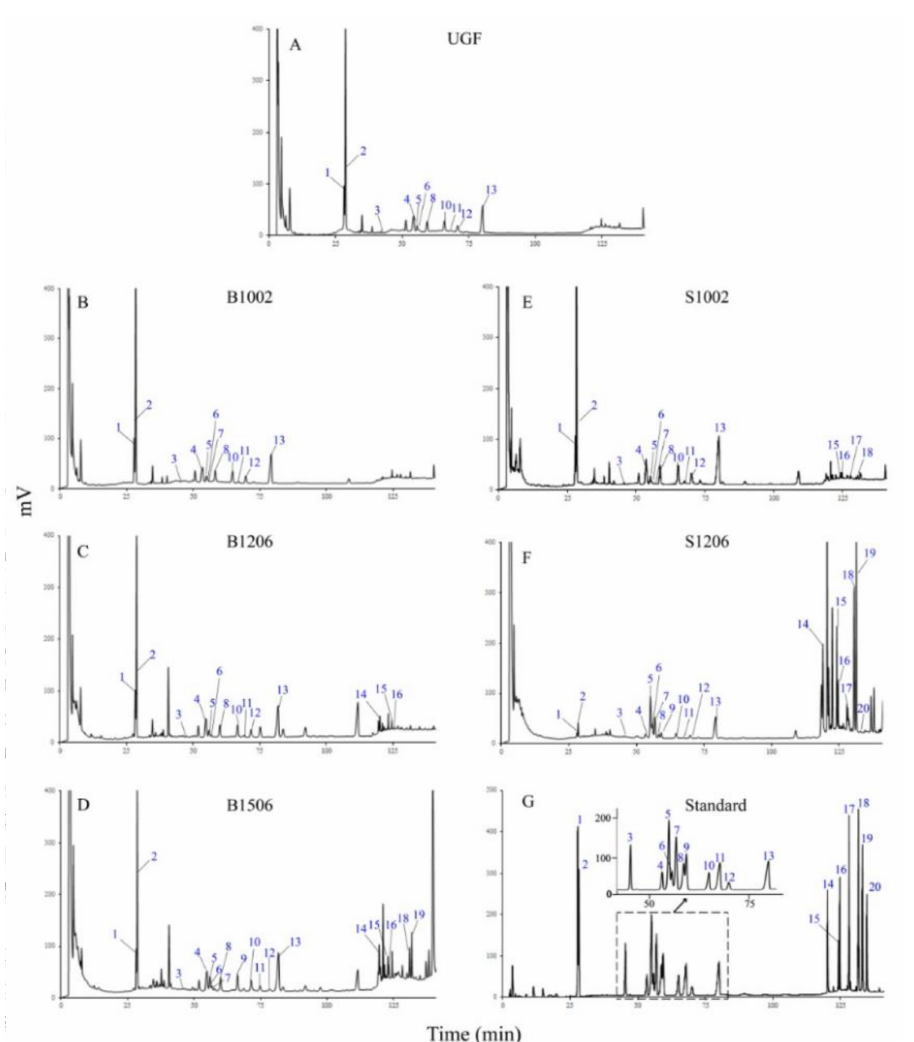
Figure 1. HPLC analyses of ginsenosides in unheated and heated ginseng flowers. Shown here are chromatograms of unheated ginseng flowers (UGF; ( A )); flowers baked for 2 h at 100 ◦ C (B1002; ( B )); 120 ◦ C (B1206; ( C )) and 150 ◦ C (B1506; ( D )); and flowers steamed for 2 h at 100 ◦ C (S1002; ( E )) and for 6 h at 120 ◦ C (S1206; ( F )); and standards of the 20 ginsenosides ( G ). Ginsenosides marked are: (1) Rg 1 , (2) Re, (3) Rf, (4) Rb 1 , (5) 20( S )-Rg 2 , (6) 20( S )-Rh 1 , (7) 20( R )-Rg 2 , (8) Rc, (9) 20( R )-Rh 1 , (10) Rb 2 , (11) Rb 3 , (12) F 1 , (13) Rd, (14) F 4 , (15) 20( S )-Rg 3 , (16) 20( R )-Rg 3 , and (17) 20( S )-PPT, (18) Rg 5 , (19) CK, and (20) Rh 2 . Peak numbers of the 20 standard ginsenosides not shown were not detected in the corresponding flower samples. An inset within Figure 1G is an amplification of the partial profile between 40 and 85 min as indicated by the dashed